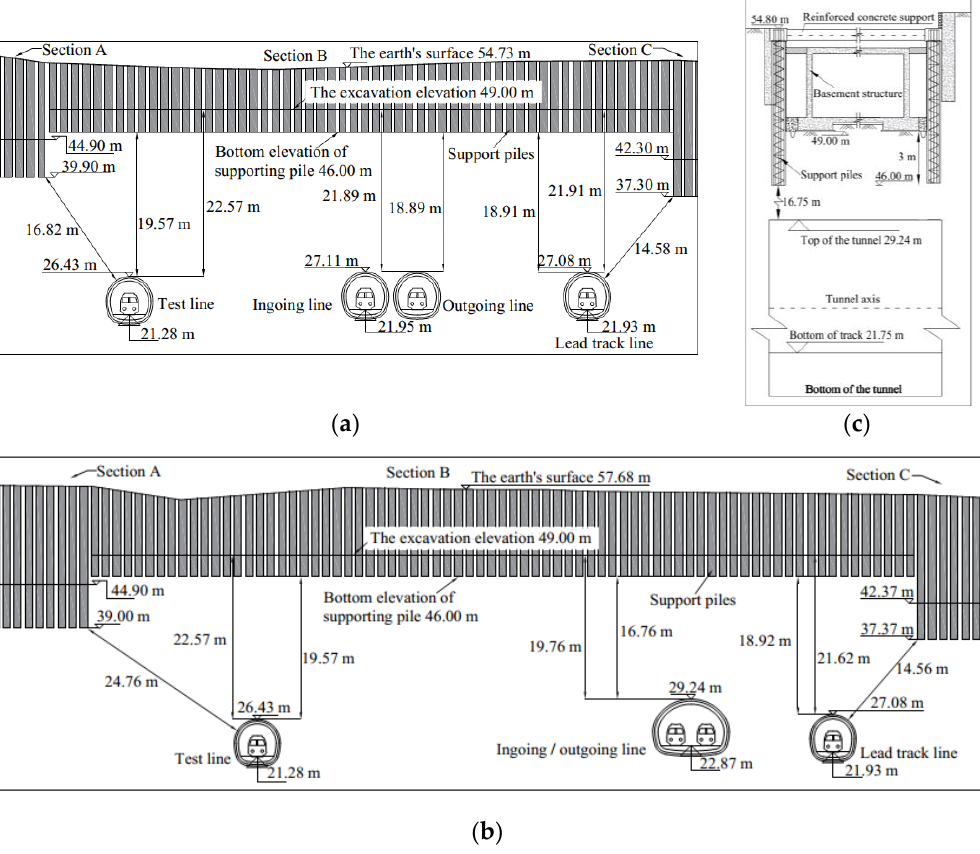
Figure 1. Plan layout of tunnels and pit. Table 1. Excavation information.